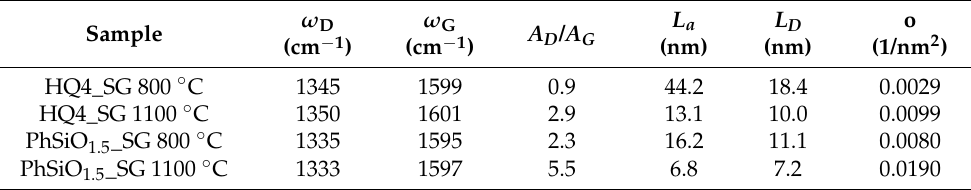
Table 4. Raman graphitization parameters for all samples reported in this